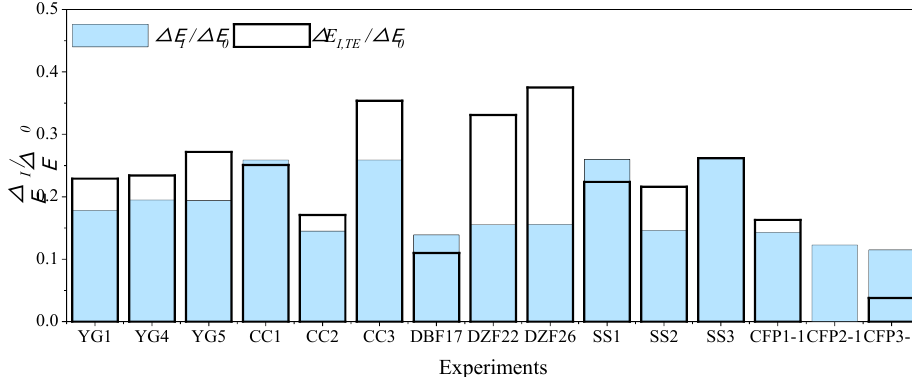
Figure 9. Results of the qualitative analysis.